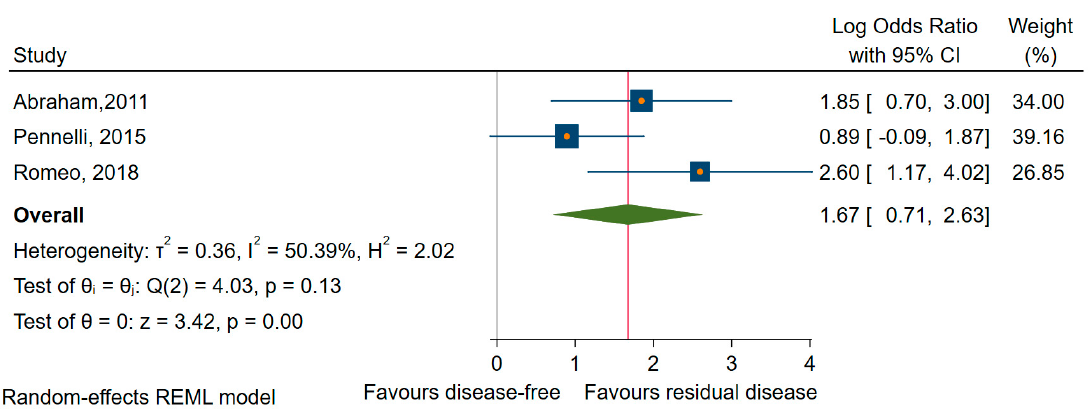
Figure 11. Forest plot of the association between the upregulated miRNAs and residual disease in MTC.